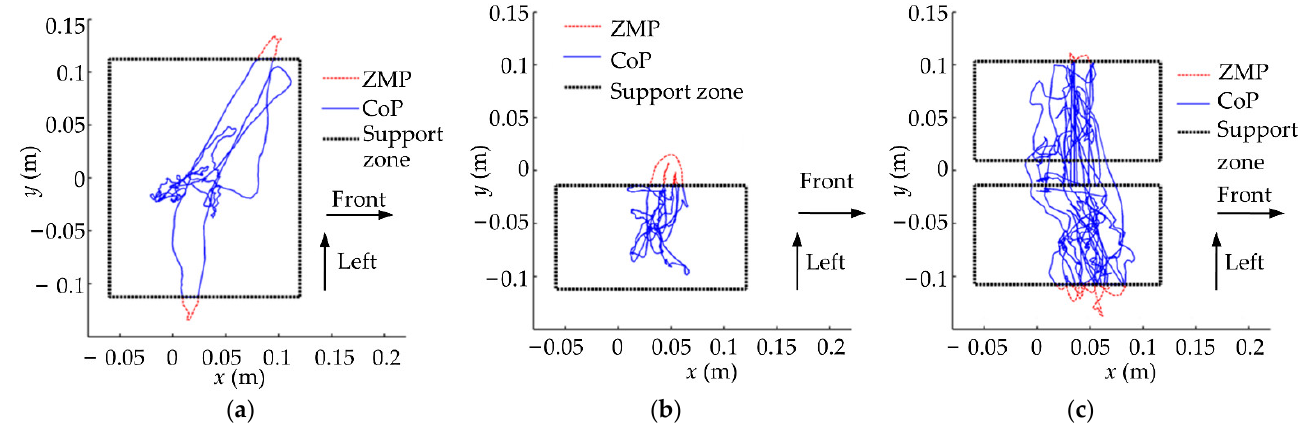
Figure 19. ZMP curves in three experiments. ( a ) Double-leg stance; ( b ) single-leg stance; ( c ) stepping.